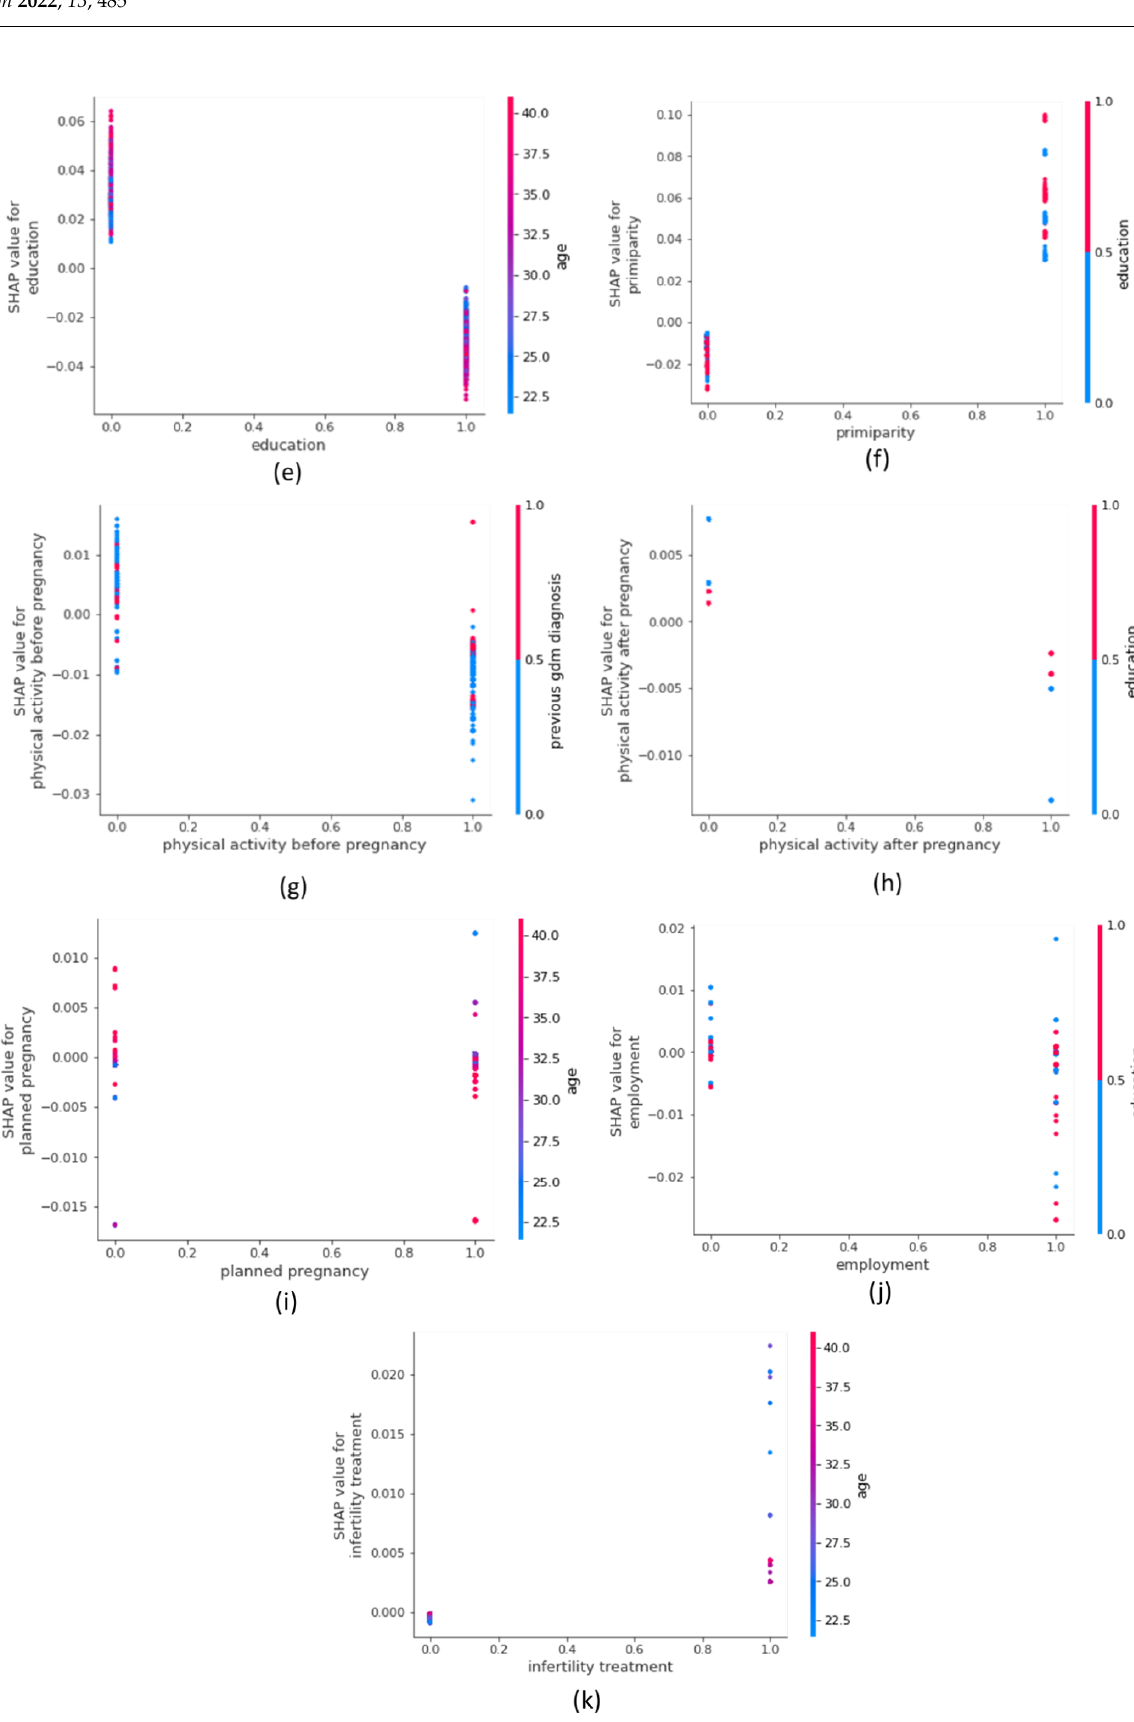
Figure 4. SHAP dependence plots for features versus its SHAP